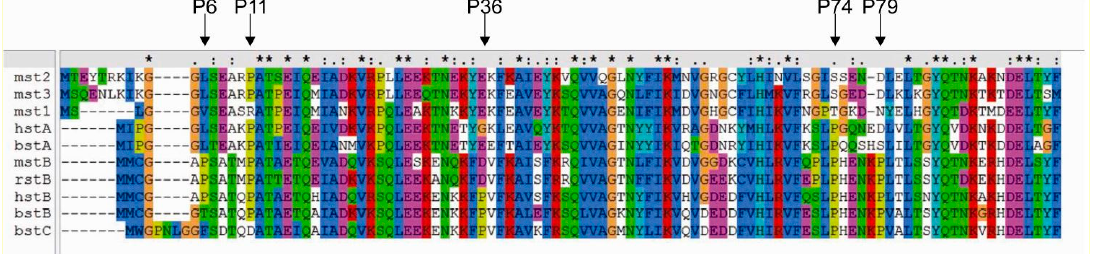
Figure 2. Sequence alignment of different stefins. Mouse stefin B (mstB), human stefin A (hstA), rat stefin B (rstB), mouse stefin 1 (mst1), mouse stefin 2 (mst2), mouse stefin 3 (mst3), bovine stefin A (bstA), bovine stefin B (bstB) and bovine stefin C (bstC) were compared against human stefin B (hstB). Sequences were retrieved from UniProt database. The multiple sequence alignment was performed with ClustalX [42]. All five proline residues (P6, P11, P36, P74 and P79) are indicated with an arrow.